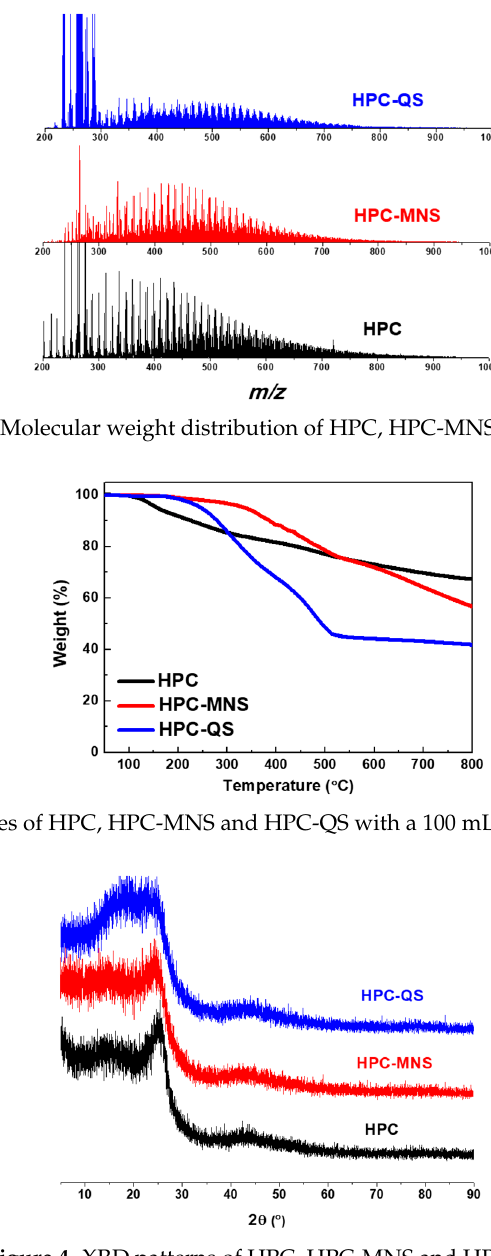
Figure 4. XRD patterns of HPC, HPC-MNS and HPC-QS.